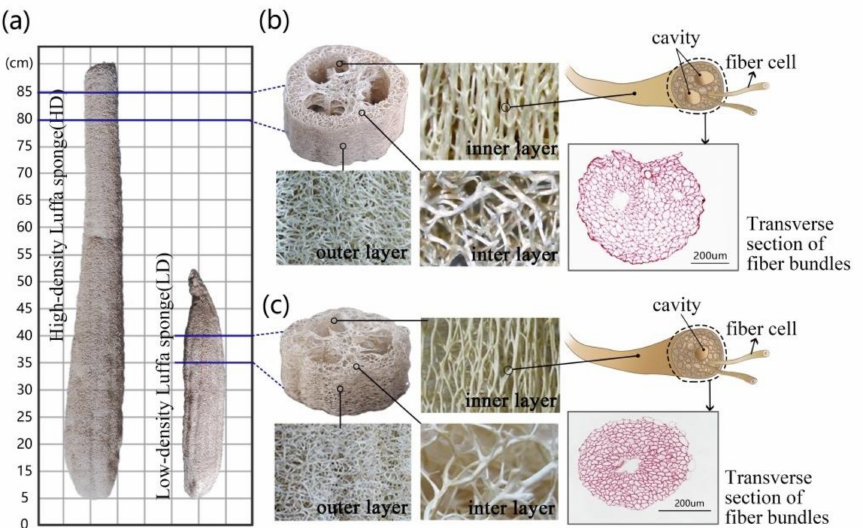
Figure 1. ( a ) high-/low-density luffa sponge; ( b ) high-density luffa sponges and their macro/micro structures; and ( c ) low-density luffa sponges and their macro/micro